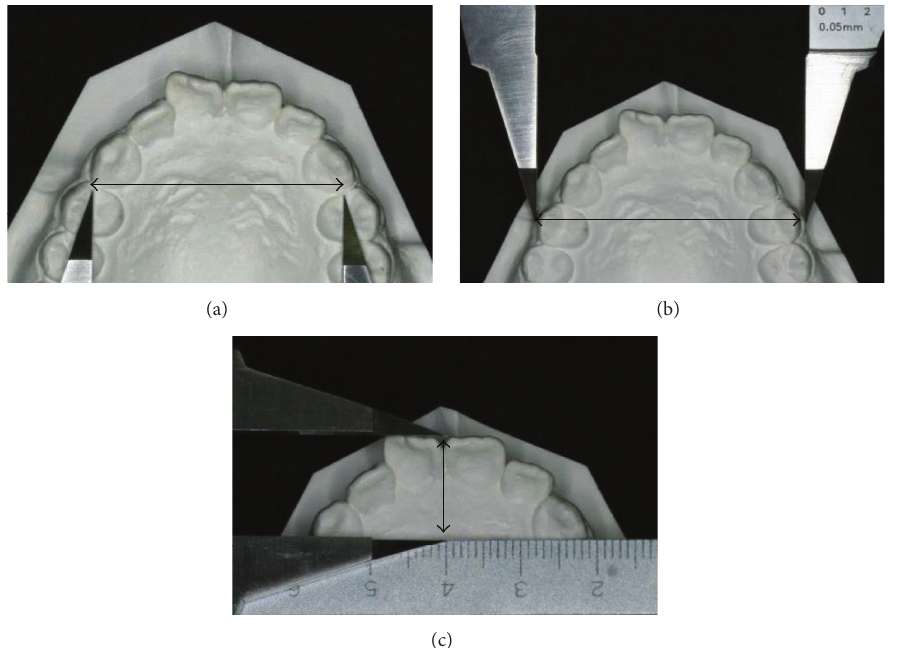
Figure 3: (a) Intercanine width; (b) basal arch width; and (c) anterior